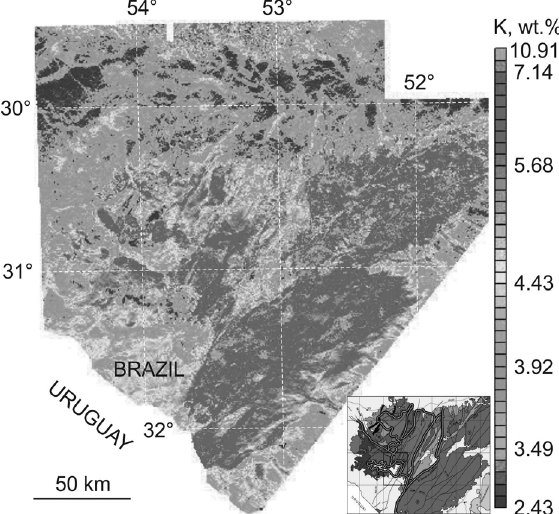
Figure 7 - Total K (%) signal over the Sul-Riograndense Shield. For interpretation of the references to color in this fi gure legend, the reader is referred to the web version of this article.